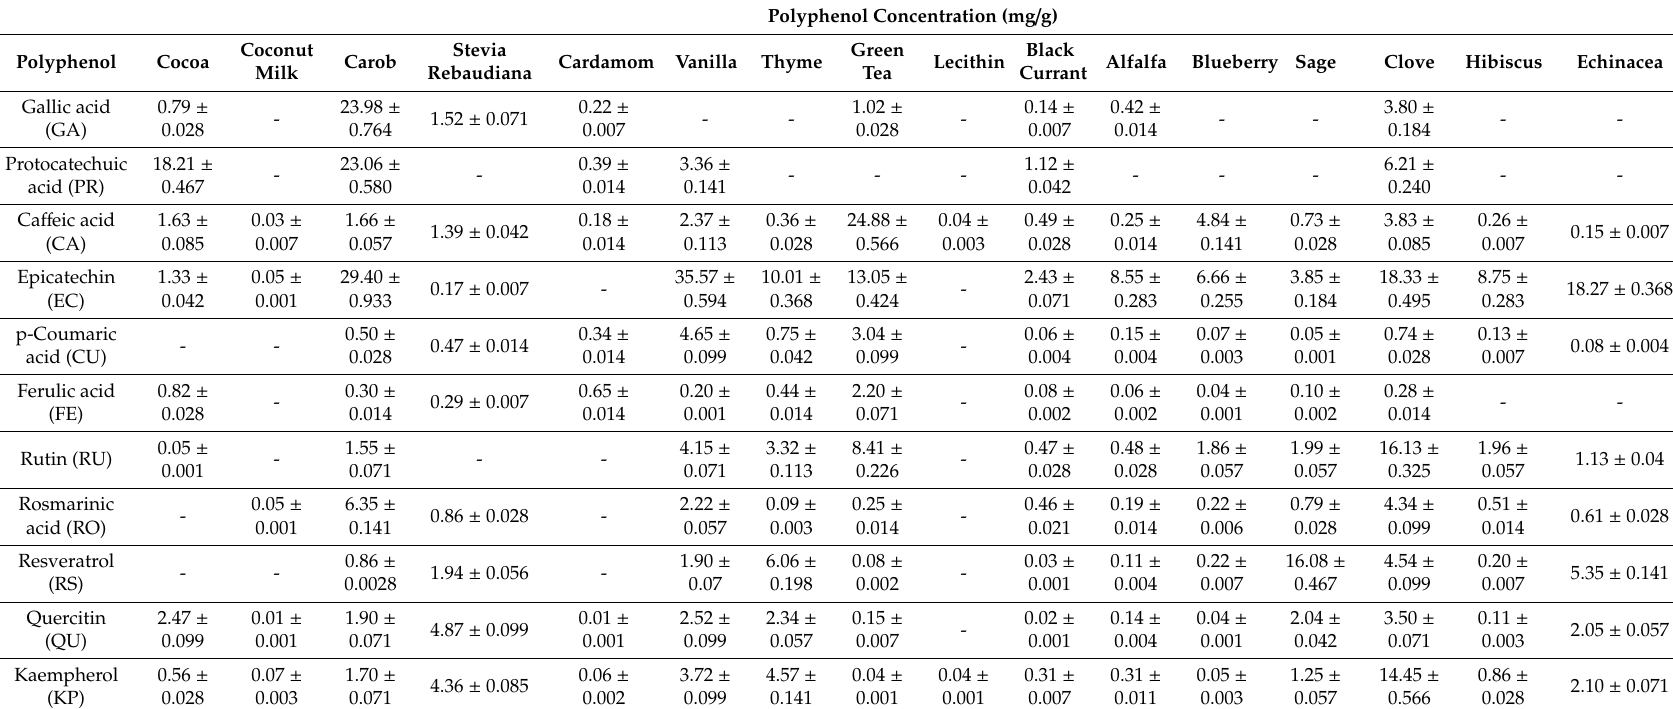
Table 3. Individual polyphenols in raw